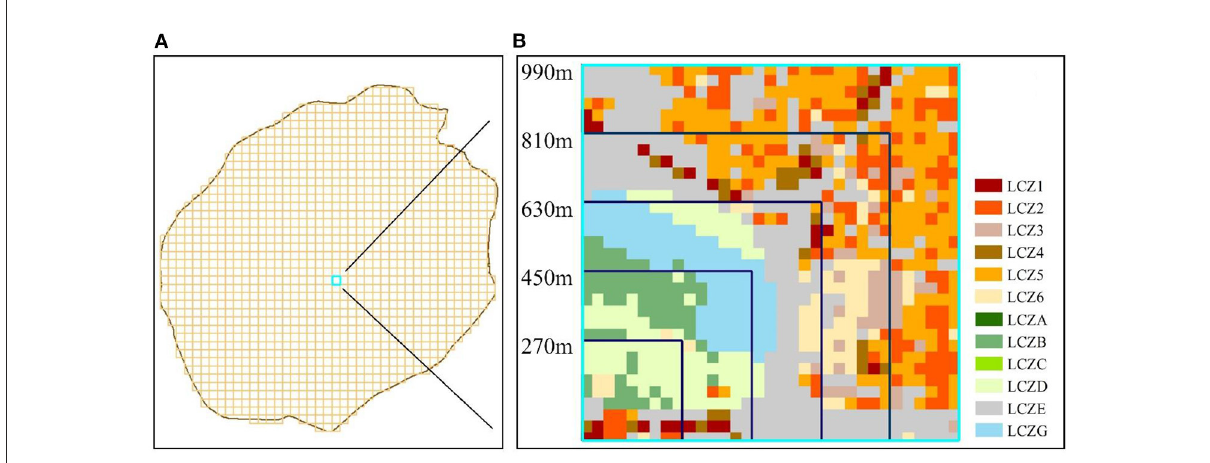
FIGURE3 Division of the first-level grid; (A) 990m grid covering the study area. (B) Number of LCZ covered by grids of different scales.